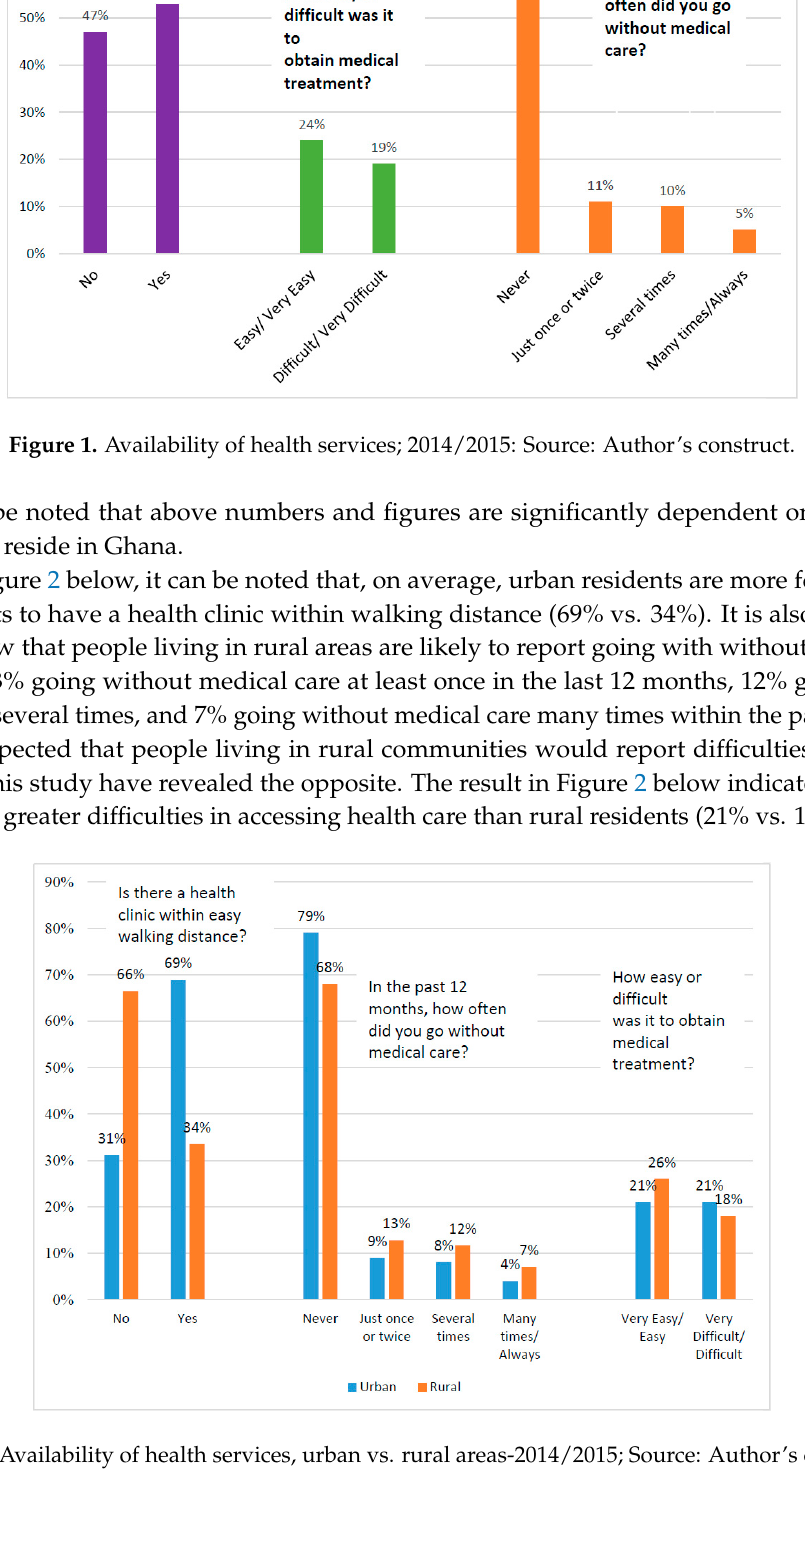
Figure 2. Availability of health services, urban vs. rural areas-2014/2015; Source: Author’s construct.